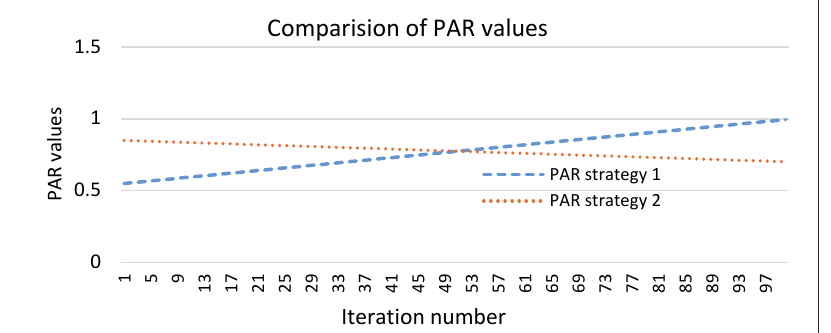
Fig. 5. Change in PAR with iteration